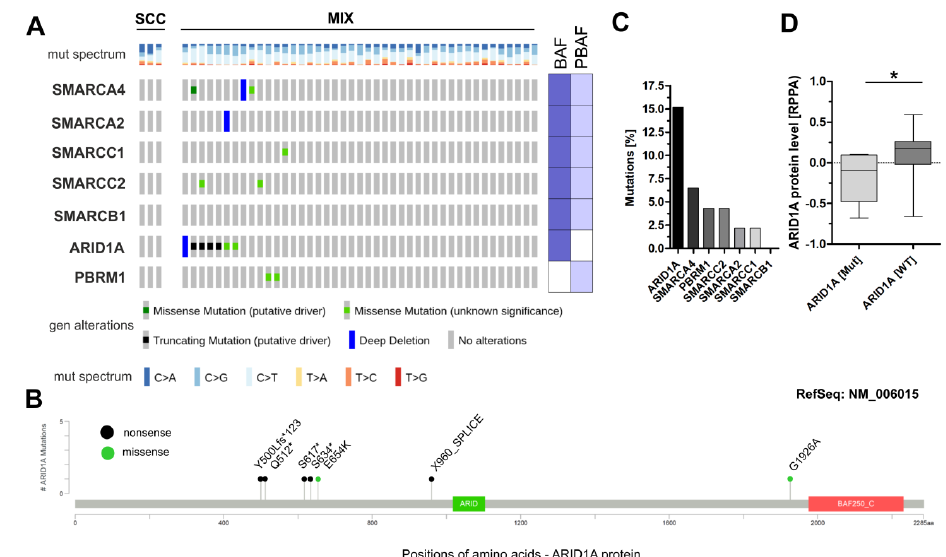
Figure 1. SWI/SNF alterations and ARID1A protein expression in the sq-BLCA cohort of the TCGA network. ( A ) Genetic alterations of different subunits of the SWI/SNF complex (including missense mutations, truncating mutations, amplifications and deep deletions). ( B ) Mutation Mapper illustrating positions of identified ARID1A alterations (nonsense and missense) relative to the protein sequence and domains (green and red box). Protein domains are indicated according to PFAM: green box: ARID domain; red box: BAF250_C domain. ( C ) Mutational frequencies of analyzed subunits of the SWI/SNF complex. ( D ) Box plots illustrating ARID1A protein expression classified by ARID1A mutations. BAF (dark blue): BRG1/BRM-associated factor; PBAF (light blue): polybromo-associated BAF; MUT: mutated; WT: wildtype. * p < 0.05.